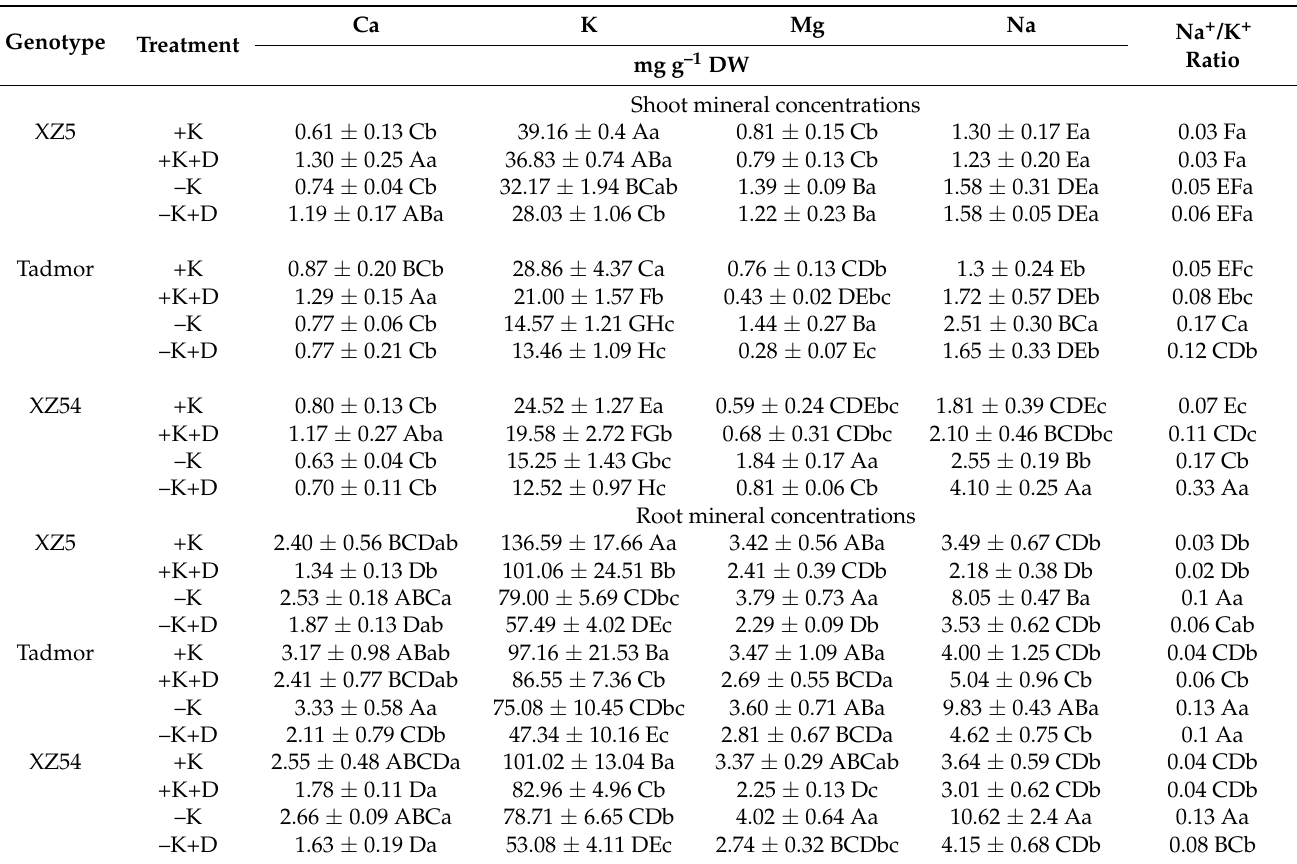
Table 2. Effect of K nutrition on shoot and root Ca, Na, K, Mg concentrations and Na + /K + ratio of three barley genotypes in response to drought